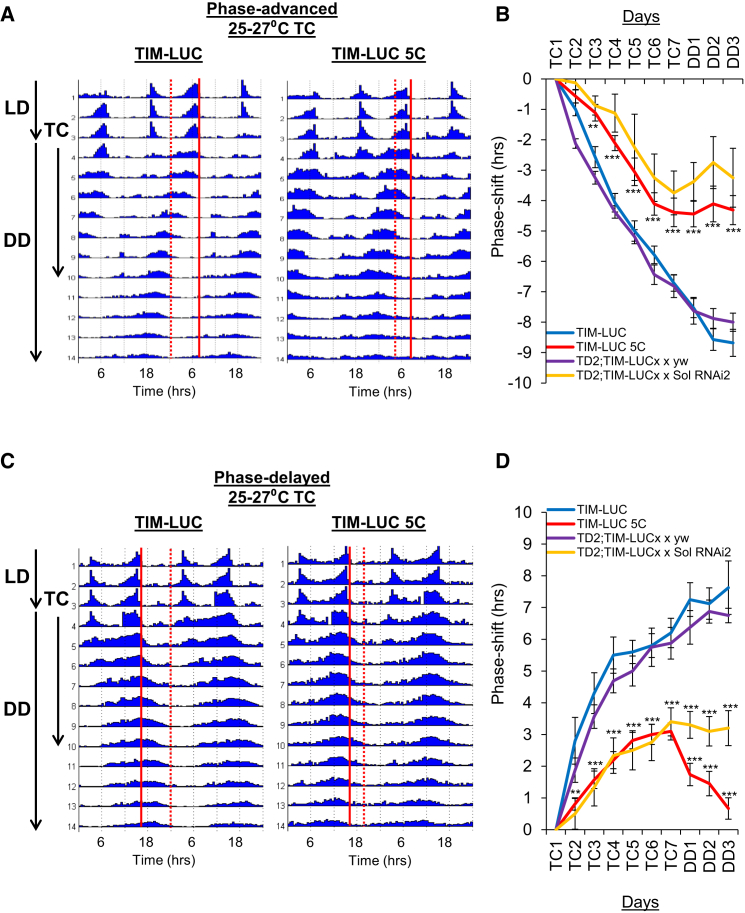
CaM Binding Mutations and SOL RNAi Impair Thermal Entrainment(A) Representative actograms of flies entrained to a 12/12-hr LD cycle for 4 days at 25°C, then to an 8-hr advanced temperature cycle (TC) of 25°C/27°C for 7 days in DD, and finally released to constant 25°C in DD. Red bars indicate the circadian phase before (solid) and after TC (dashed).(B) Quantification of circadian phases from at least five independent advanced TC experiments (n ≥ 8 each) is shown.(C and D) Similar experiments using an 8-hr delayed TC and their quantification from at least five independent experiments (n ≥ 8 each) are shown. Error bars represent SEM for (B) and (D). p < 0.01 or p < 0.001 is indicated with “∗∗” or “∗∗∗,” respectively.See also Figure S5.